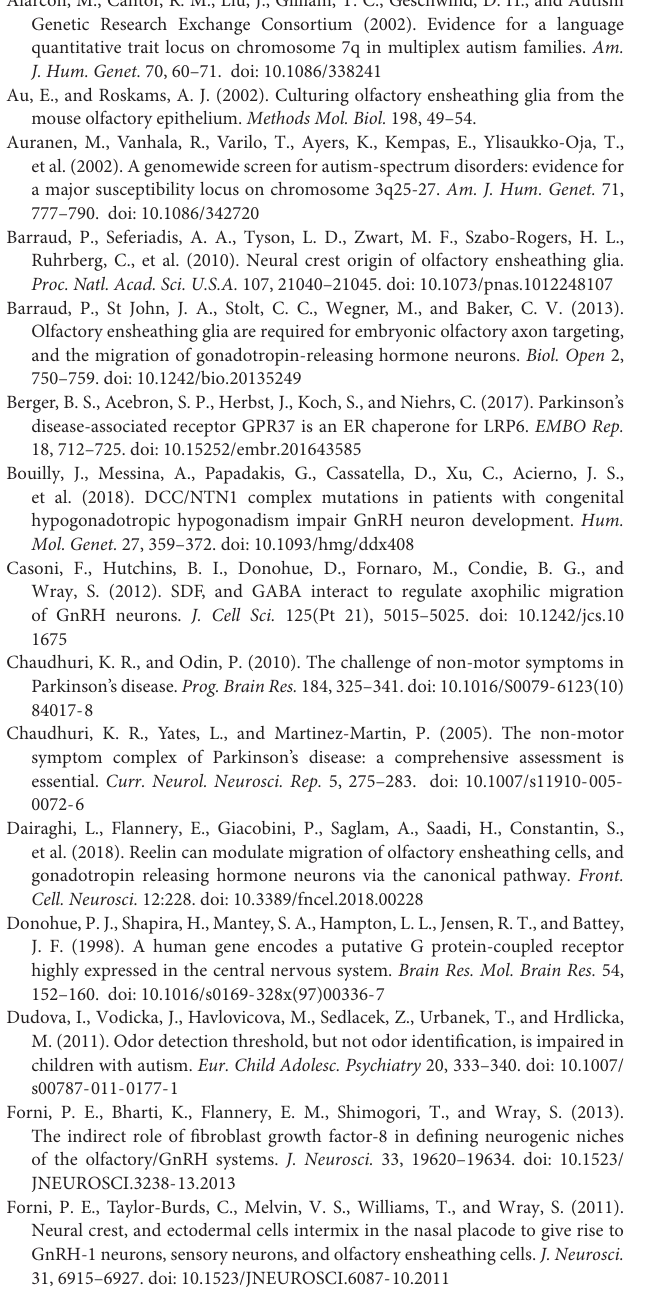
FIGURE S2 | GPR37 is not expressed by olfactory axons in vivo . Imaris generated surface rendering processed from confocal stack, one of which is shown in Figure 2 E11.5. Reconstruction shows GPR37 negative “channels” (arrowheads) in GPR37 positive tracks (green). These “channels” contained peripherin positive fibers (red, arrows). Scale: 30 µ m. FIGURE S3 | GPR37 is not expressed by olfactory axons in vitro . (A) 4DIV explant stained for peripherin (red, mouse antibody), which marks olfactory axons and GPR37 (green, rabbit antibody). In vitro, as in vivo , migratory tracks are composed